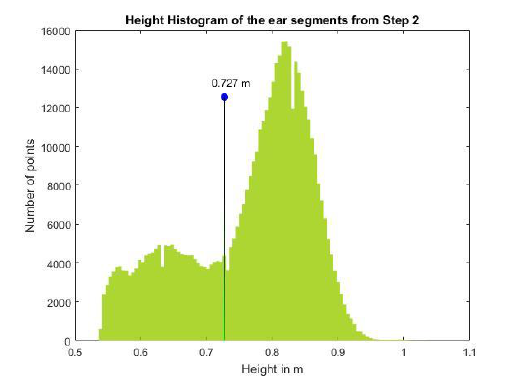
Figure 6 Height histogram showing the two distinct peaks between the ear and non-ear segments. The line at 0.727 m denotes the threshold chosen from Otsu's thresholding.